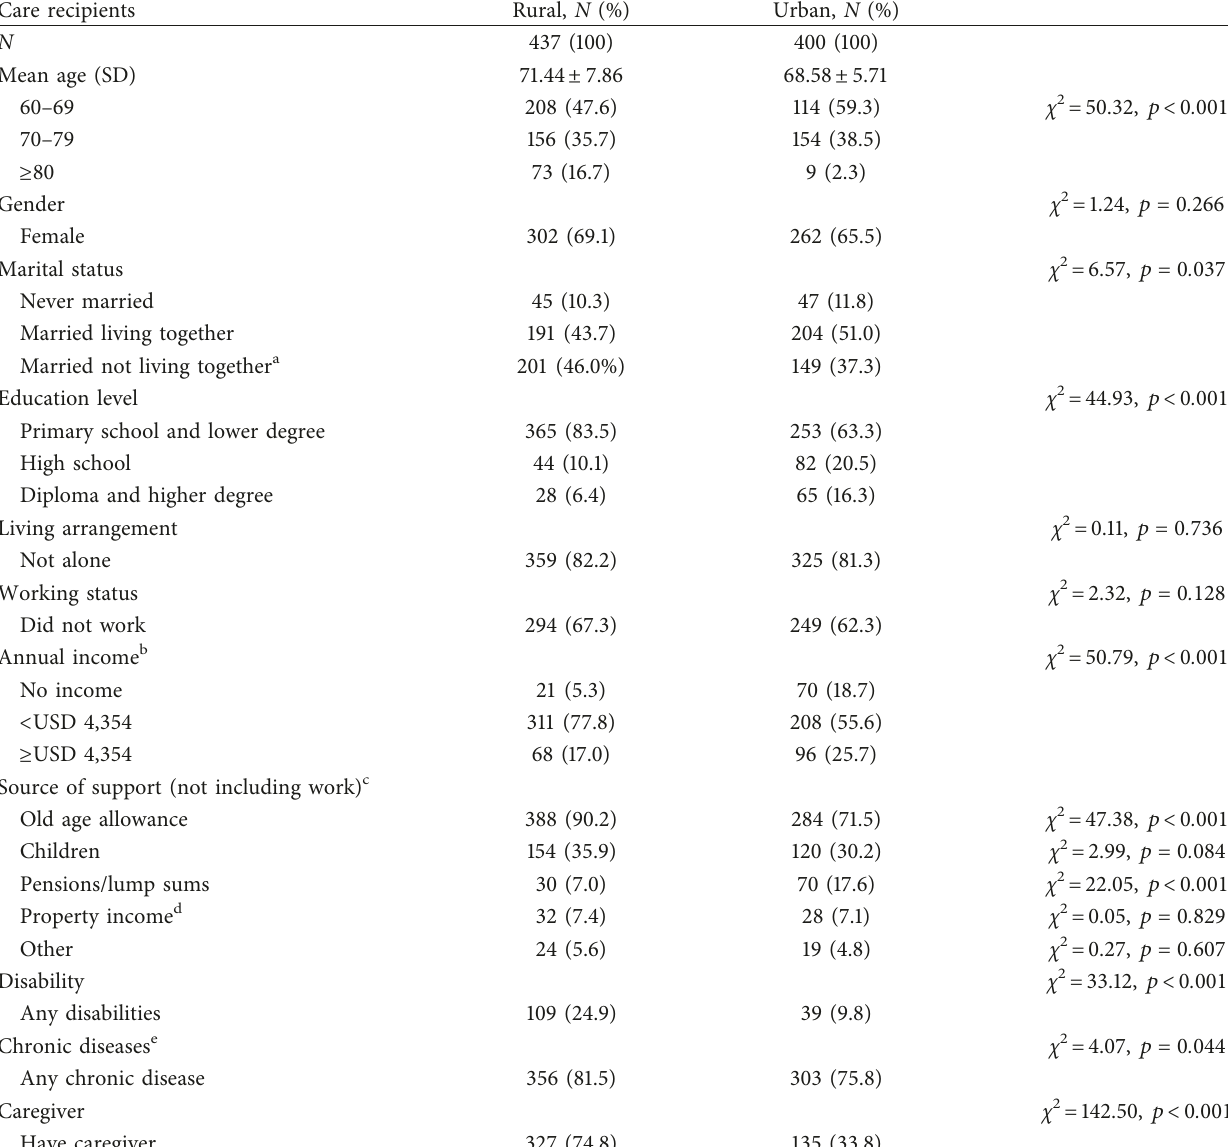
Table 3: Characteristics of elderly in study area ( N �